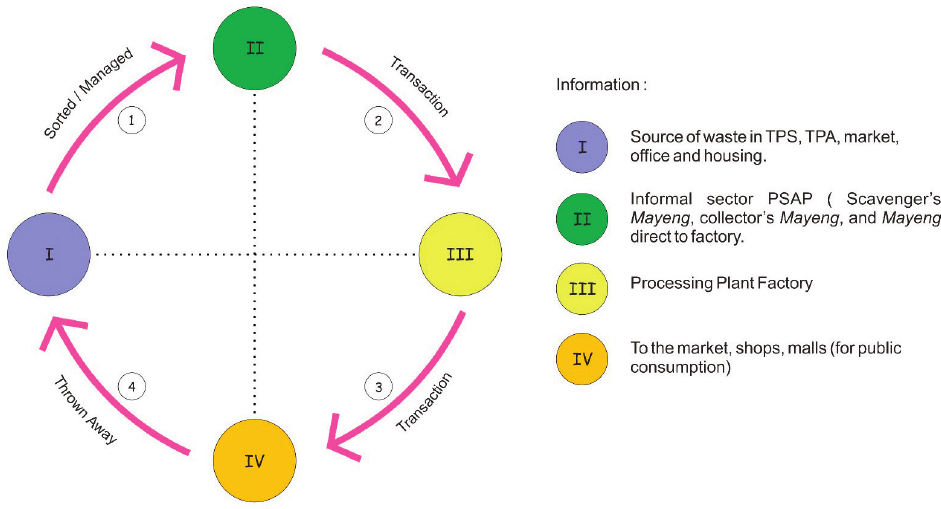
Fig. 1. Informal Sector of Anorganic Waste’s Management